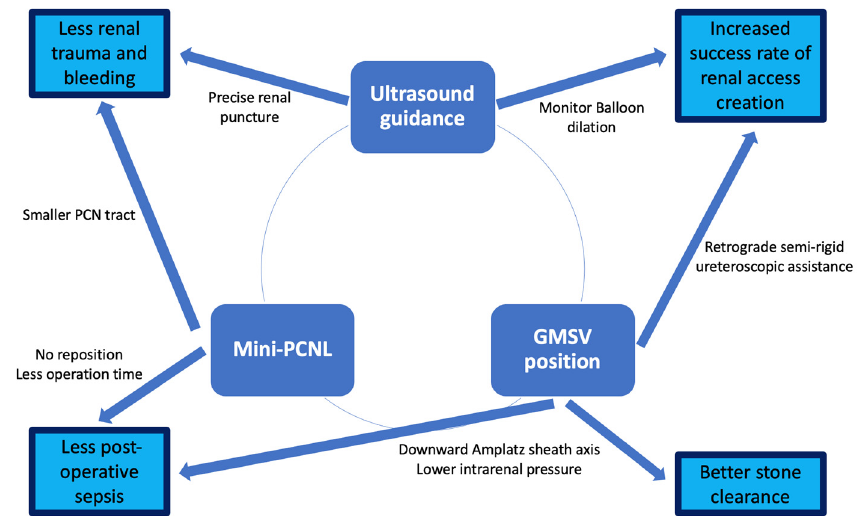
Figure 1. Three core techniques and their effects on surgical outcomes.